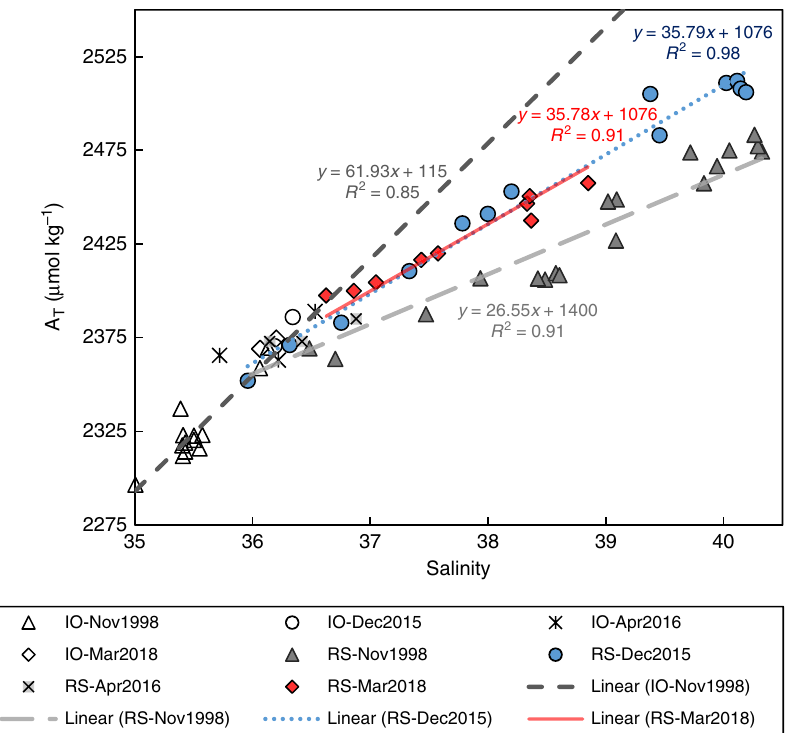
Fig. 3 Surface water total alkalinity versus salinity. The fi gure includes all surface water samples collected from the Indian Ocean (IO), Arabian Sea, Gulf